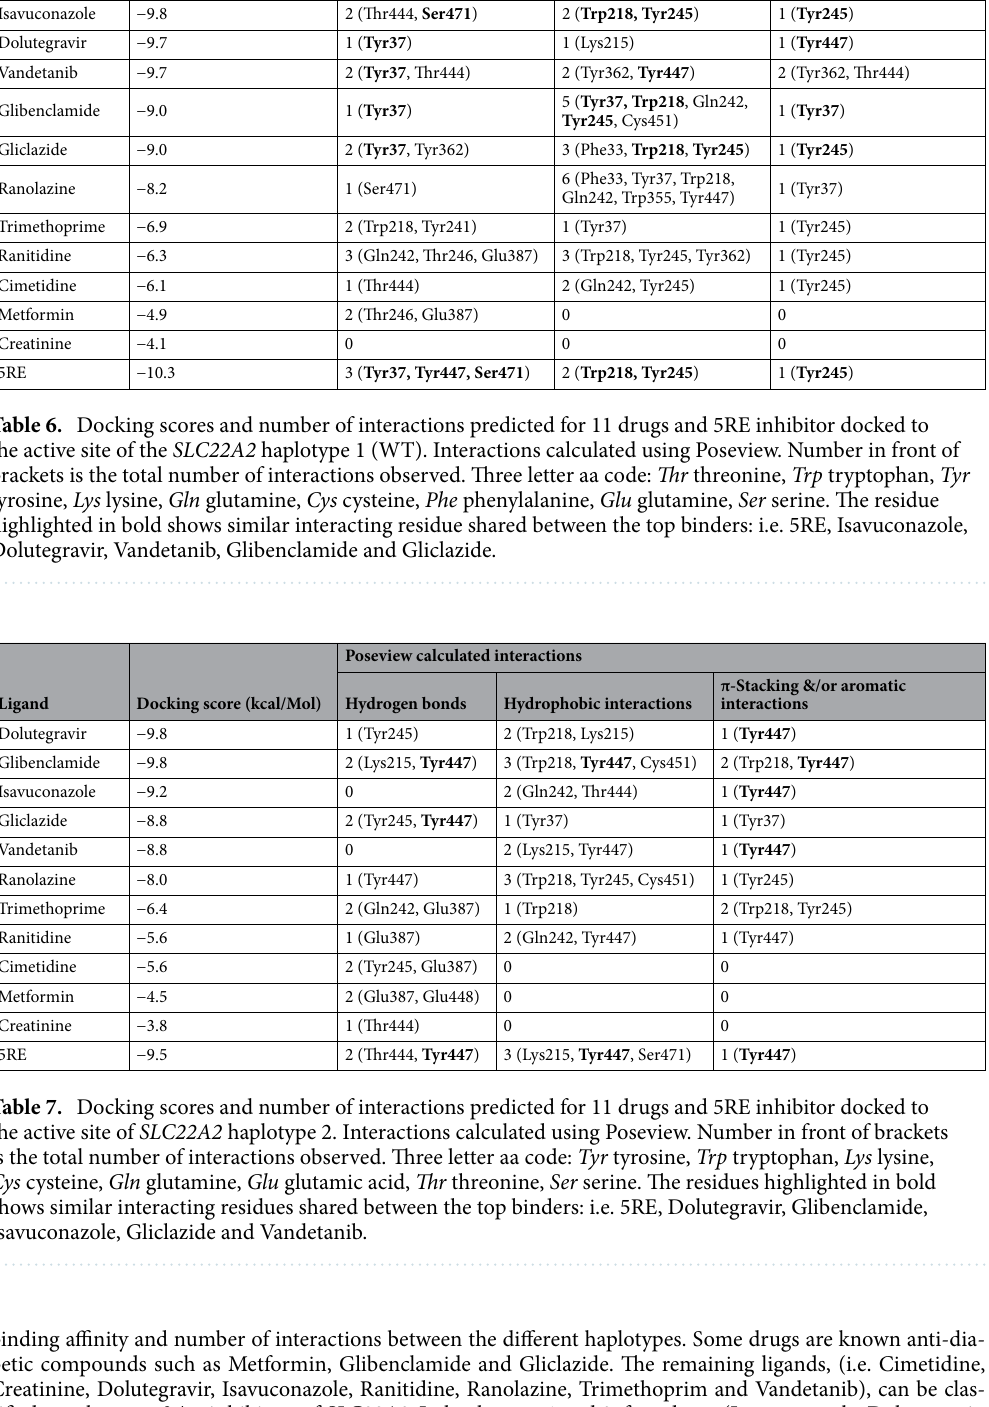
Table 7. Docking scores and number of interactions predicted for 11 drugs and 5RE inhibitor docked to the active site of SLC22A2 haplotype 2. Interactions calculated using Poseview. Number in front of brackets is the total number of interactions observed. Three letter aa code: Tyr tyrosine, Trp tryptophan, Lys lysine, Cys cysteine, Gln glutamine, Glu glutamic acid, Thr threonine, Ser serine. The residues highlighted in bold shows similar interacting residues shared between the top binders: i.e. 5RE, Dolutegravir, Glibenclamide, Isavuconazole, Gliclazide and Vandetanib.